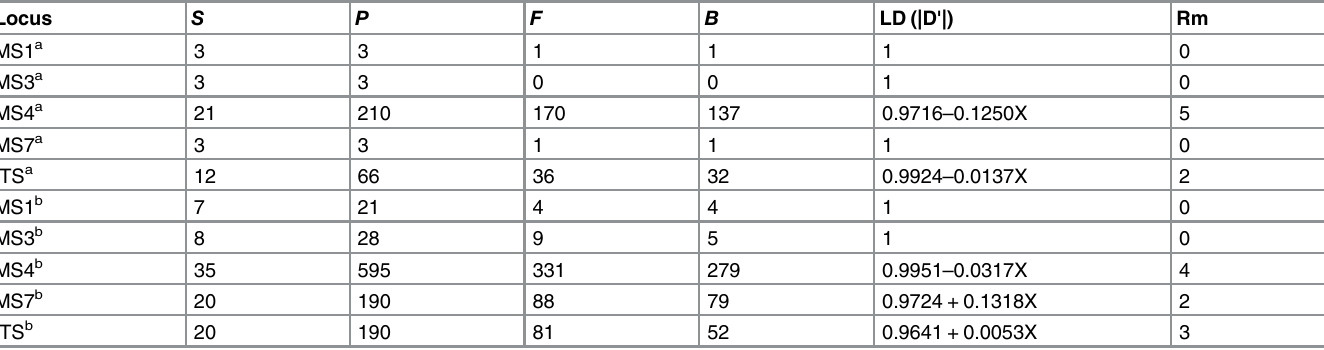
were the only source of genetic diversity at the ITS locus, while genetic variation at the other four loci included the lengths of trinucleotide TAC and TAA repeats at MS1, dinucleotide TA repeats at MS3, tetranucleotide GGTA repeats at MS4, and TAA repeats at MS7 and the SNPs outside the tandem repeat regions. Some MS4 fragments also carried isostructural GG to AA substitutions in the first tetranucleotide repeat. Gene diversity (Hd) at individual loci was cal- culated using DnaSP and is shown in Table 2. The number of genotypes and Hd value of each locus were also measured for 106 primate E . bieneusi isolates (Table 2). Generally, markers MS1 and MS4 had higher resolution than the other ones (Table 2). The intragenic LD among segregating sites for each locus was calculated based on a linear regression analysis in DnaSP. The markers MS1, MS3, and MS7 had complete LD (LD = 1) when only the pig E . bieneusi iso- lates were analyzed, whereas only MS1 and MS3 had complete LD in the analysis of all 207 iso- lates (Table 3). Table 3 displays the number of pairwise comparisons and the number of significant pairwise comparisons after Fisher ’ s exact test and Bonferroni correction. The Table 3. Intragenic linkage disequilibrium and recombination events at individual genetic loci. Locus S P